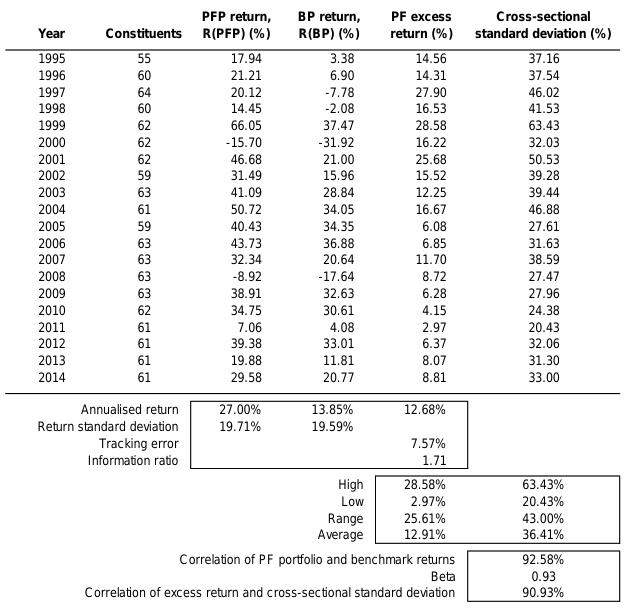
Table 4: Mid Cap segment benchmark and PF portfolio